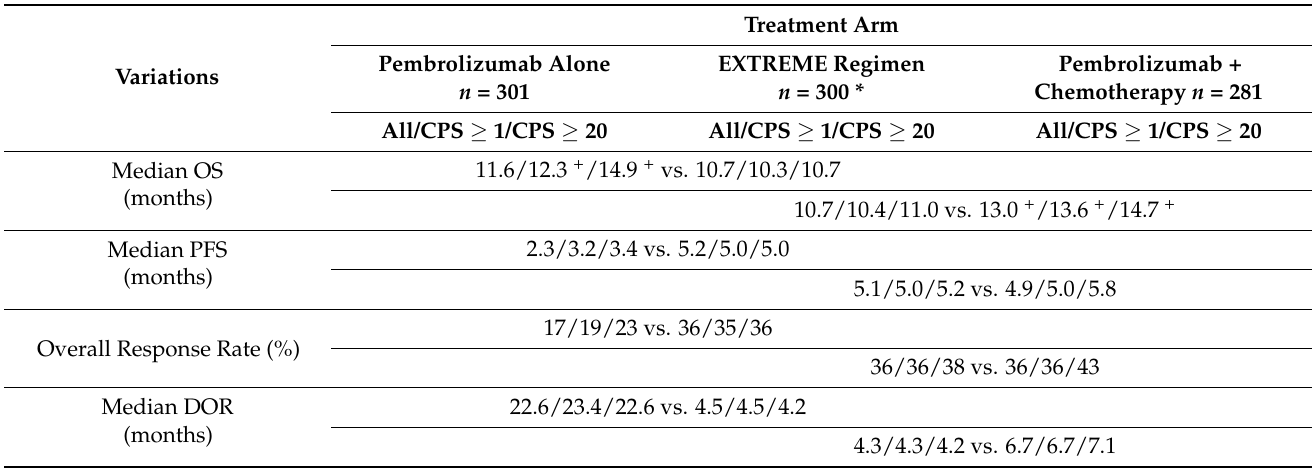
Table 1. Resumed efficacy results of the KEYNOTE-048 phase 3